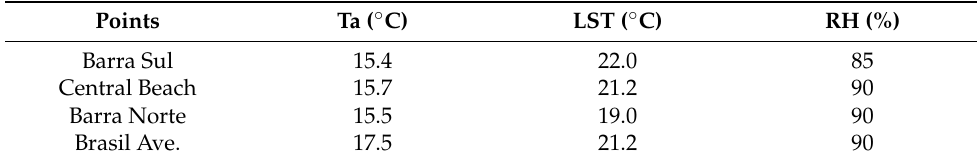
Figure 12. Land Surface Temperature estimate map ( A ), and NDVI map ( B ), for Balneário Camboriú/SC, in 26 August 2019, at 9 a.m., and relation between emissivity and LST ( C ), and NDVI and LST ( D ). Table 3. Ta and RH (6:30 a.m.) and LST (9 a.m.) in different points of Balne á rio Cambori ú /SC.